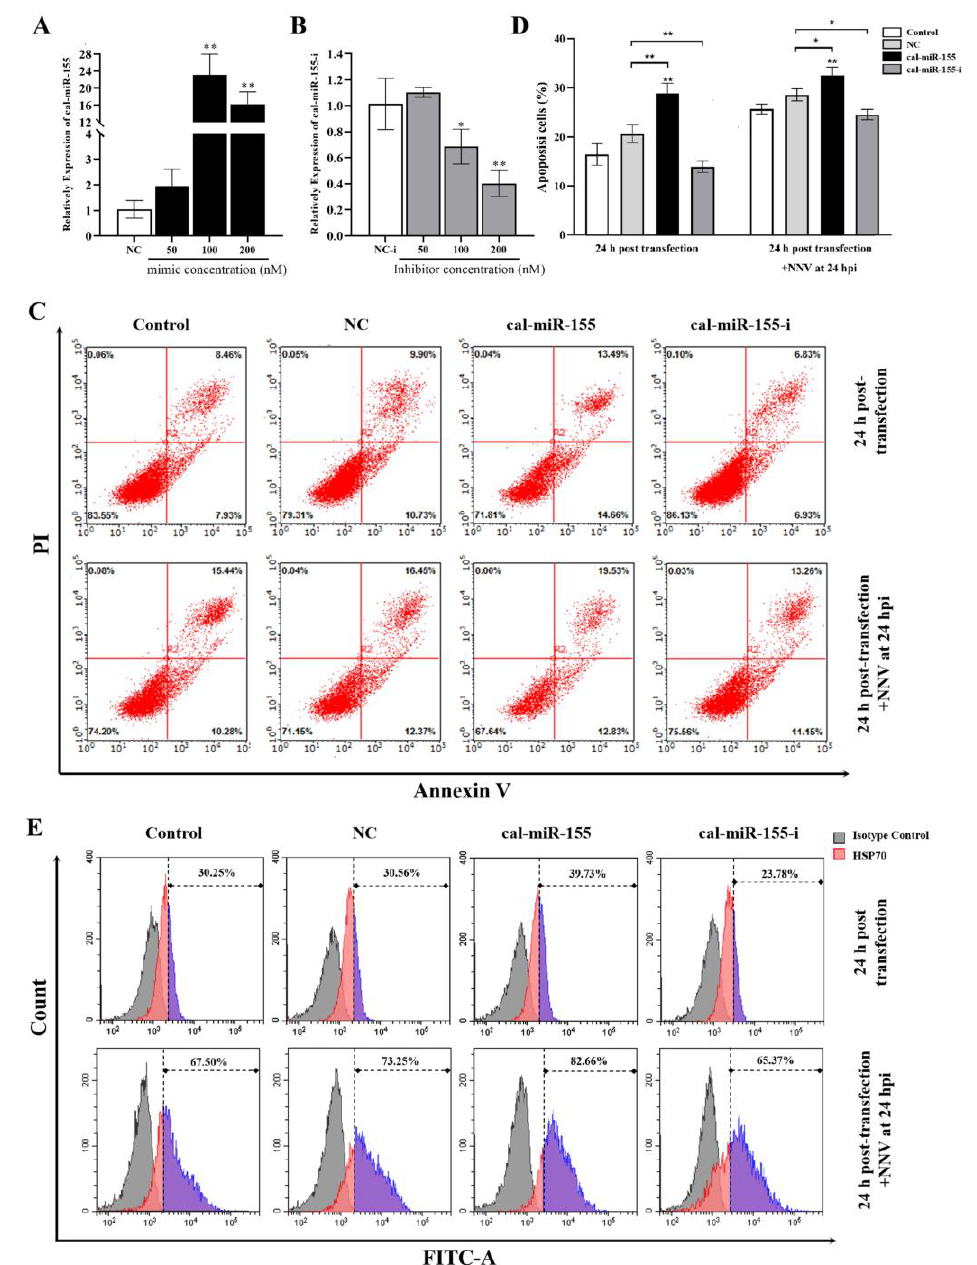
Figure 6. Cal-miR-155 enhances apoptosis in CAB cells with or without NNV infection. ( A ) The relative mRNA expression level of cal-miR-155 in CAB cells transfected with 50 nM, 100 nM and 200 nM cal-miR-155 mimic (miR-155) compared to that of cells transfected by cal-miR-155 mimic control (NC); detected by qRT-PCR after 24 h post-transfection and normalized to U6. ( B ) The relative mRNA expression level of cal-miR-155 in CAB cells transfected with 50 nM, 100 nM and 200 nM cal-miR-155 inhibitor (miR-155-i) compared to that of cells transfected by a cal-miR-155 inhibitor control (NC-i); detected by qRT-PCR after 24 h post-transfection and normalized to U6. ( C ) CAB cells transfected with miR-155, miR-155-i, or NC infected with or without NNV for 24 h, while untransfected CAB cells were used as control. Then the cells were harvested and stained with Annexin V-PE and PI, and the cell apoptosis was examined by flow cytometry. ( D ) The percentage of apoptotic cells in each group shown in panel C was graphed and statistically analyzed. Data are representative of three independent experiments and presented as means ± SD. ( E ) The HSP70 expression for those cells was measured by flow cytometry, and the gate was applied using an isotype control. The color purple represented the relatively expression level of HSP70. (** stands for p < 0.01; * stands for p <